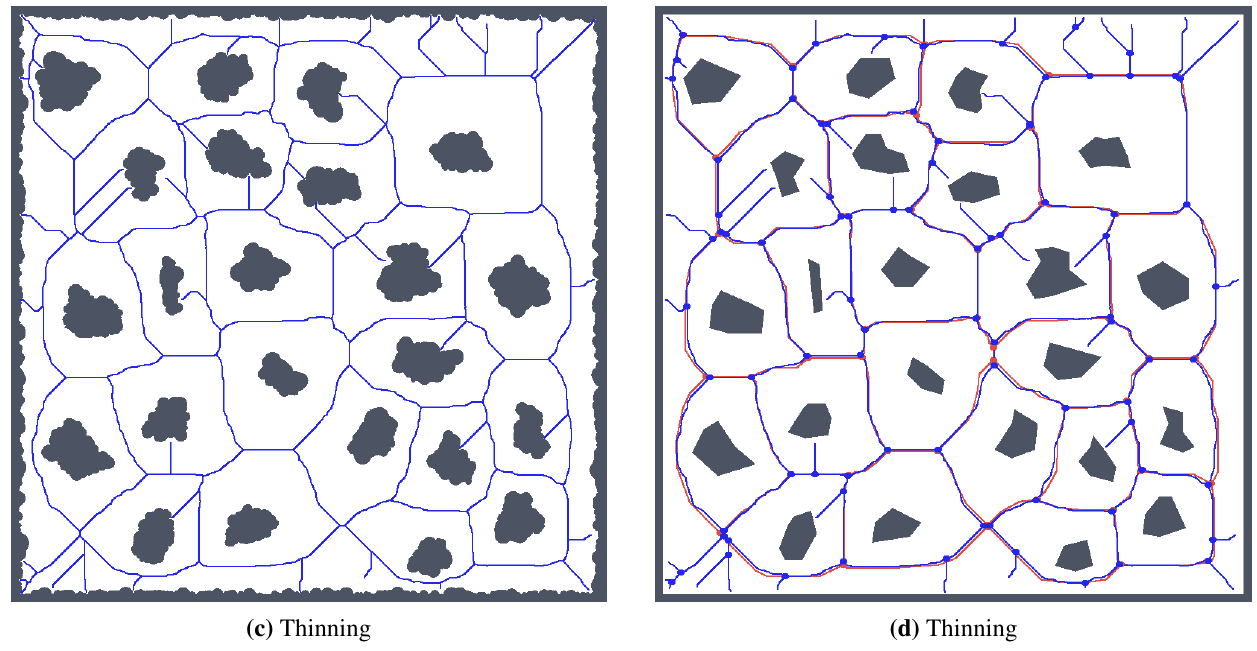
Figure 16. Determined skeletons and topological maps with highlighted junction places and leaves in the map potholes with the noise level σ = 4 : ( a ) RD-based Voronoi diagram; ( b ) and its corresponding skeleton superimposed on the skeleton determined in the noise-less map (in red); ( c ) Pruned GVG representing skeleton of the map determined by the thinning algorithm [12]; ( d ) and the corresponding skeleton superimposed on the skeleton determined in the noise-less